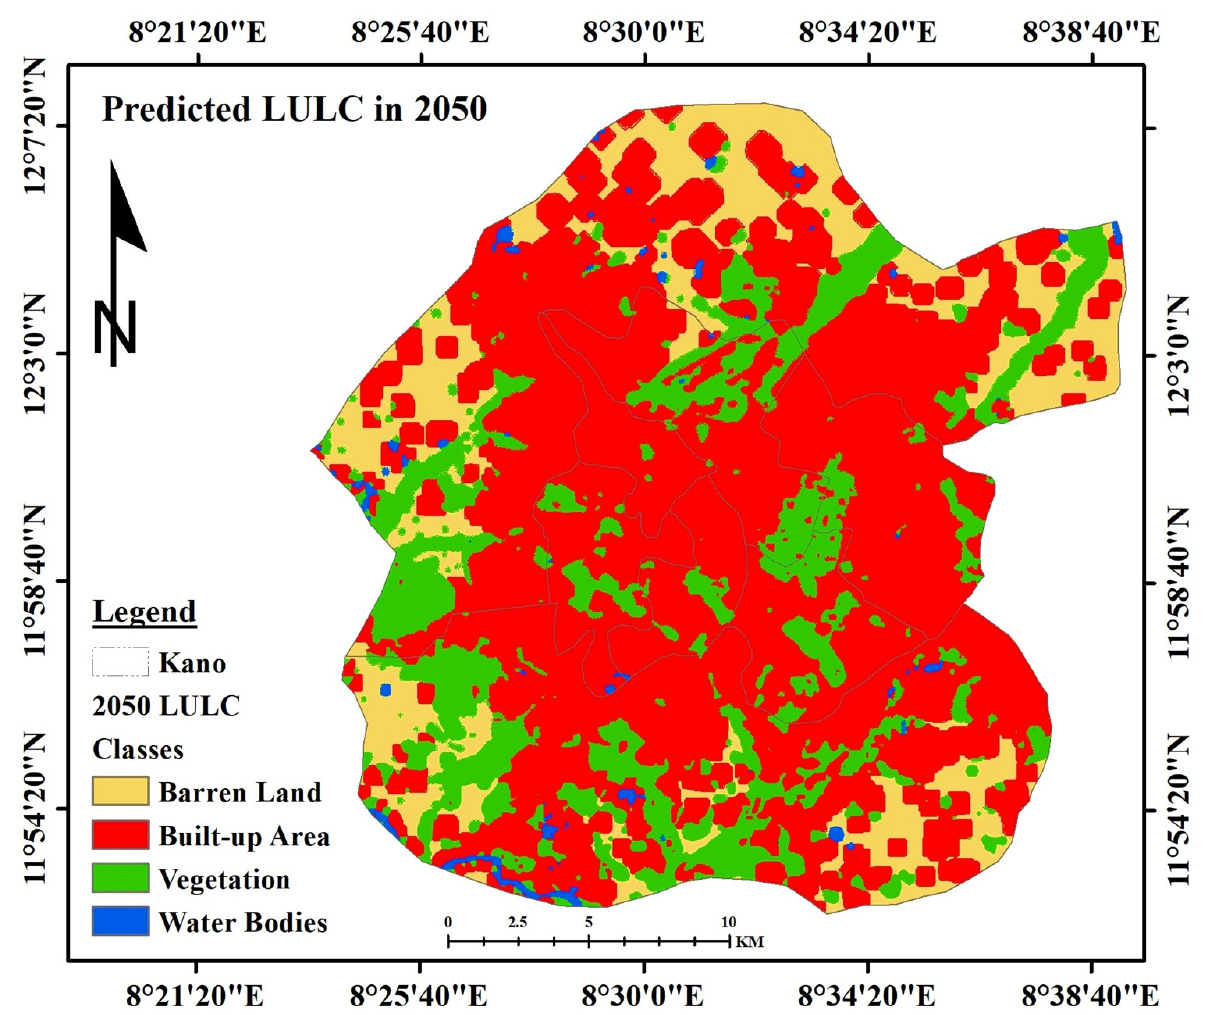
Figure 9. Mapping of predicted LULC in 2050.